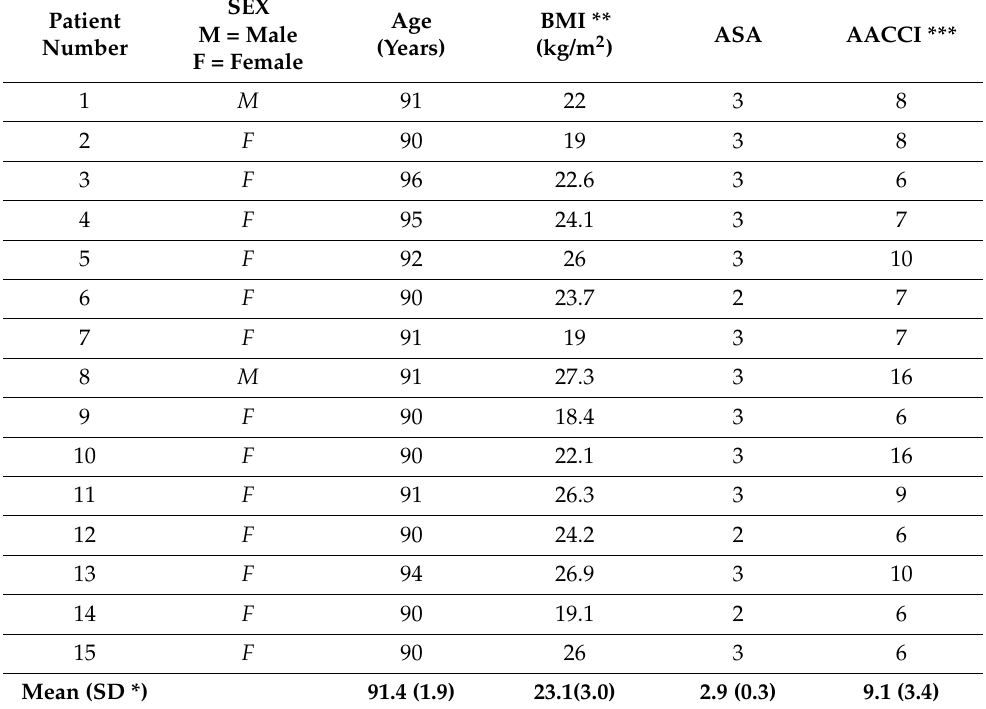
Table 2. Patients’